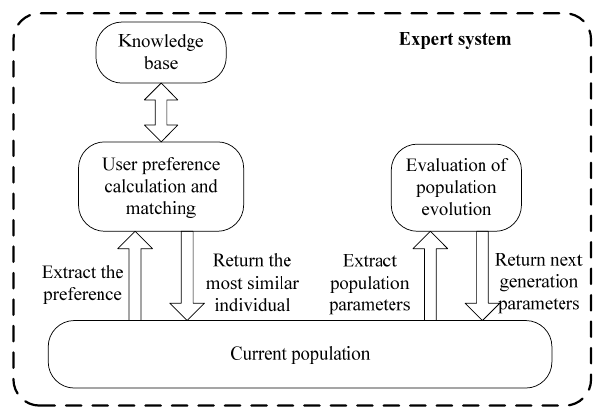
Figure 4. Structure diagram of the hearing aid expert system.